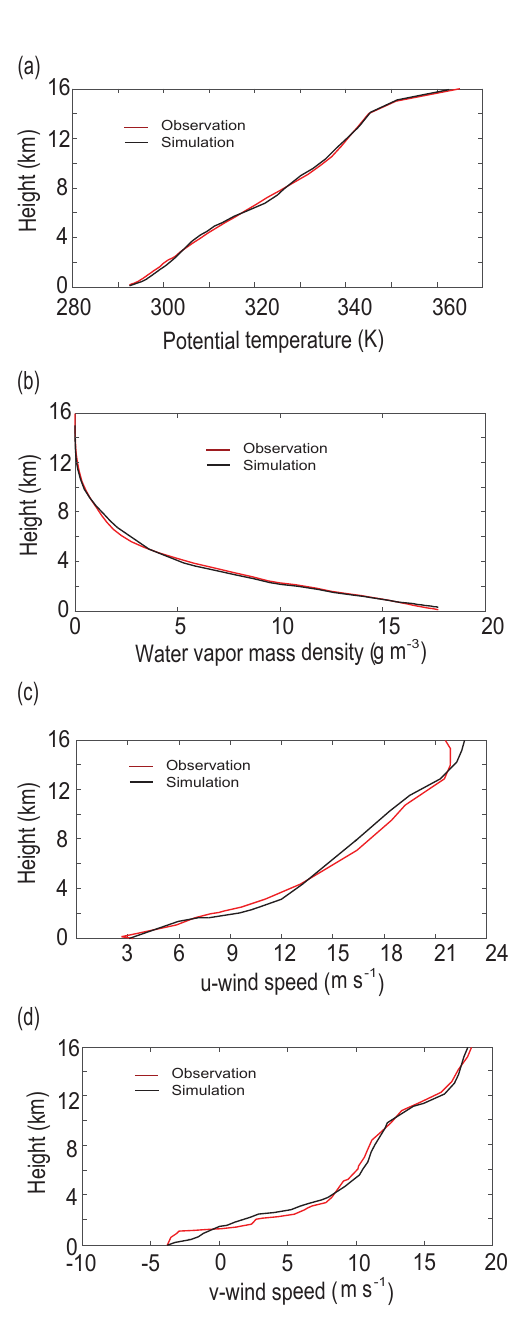
Figure 5. Vertical distributions of the averaged (a) potential tem- perature, (b) water vapor mass density, (c) u -wind speed, and (d) v - wind speed. Positive (negative) u -wind speed represents eastward (westward) wind speed, while positive (negative) v -wind speed rep- resents northward (southward) wind speed. Observations are aver- aged over observation sites in Domain 3 and the simulation period, while simulations are averaged over Domain 3 and the simulation period.